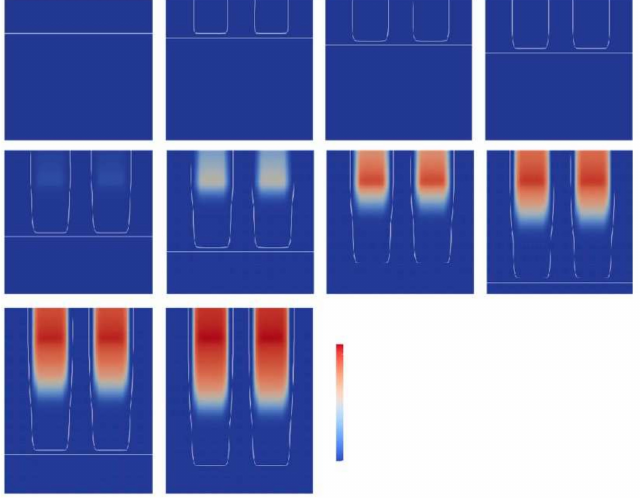
Figure 28. Contour plot showing the results of the numerical simulation of normalized oxygen concentration of 0.9 and C=C bond conversion distribution for a lift-up speed of 1 mm/s. Reprinted from reference [159] with kind permission of the